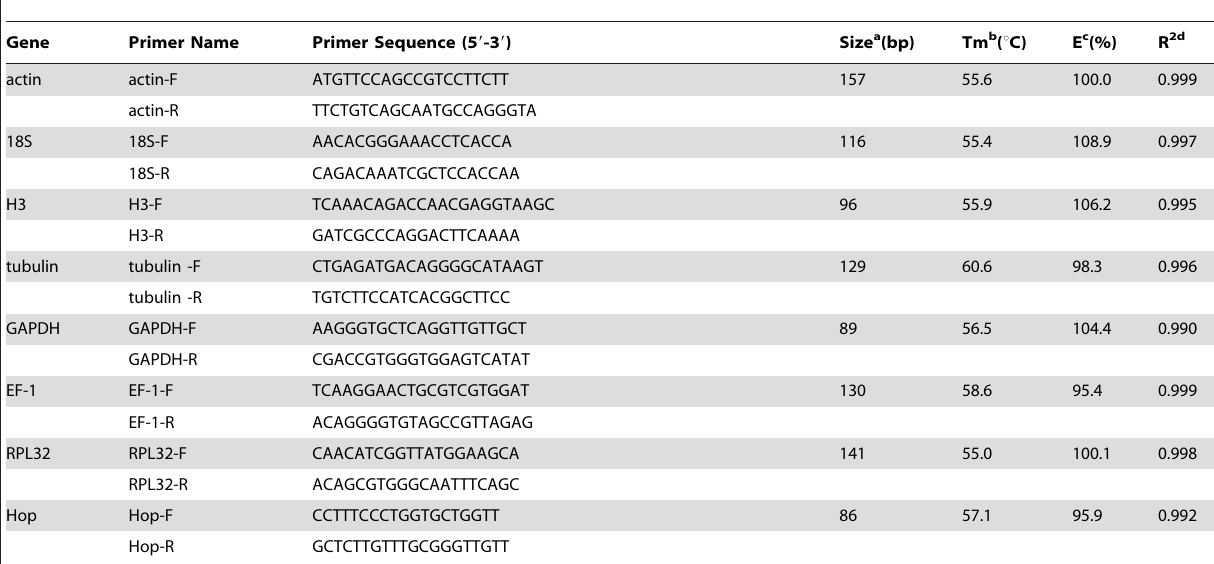
Table 1. Primer sequences and amplicon characteristics of the candidate reference